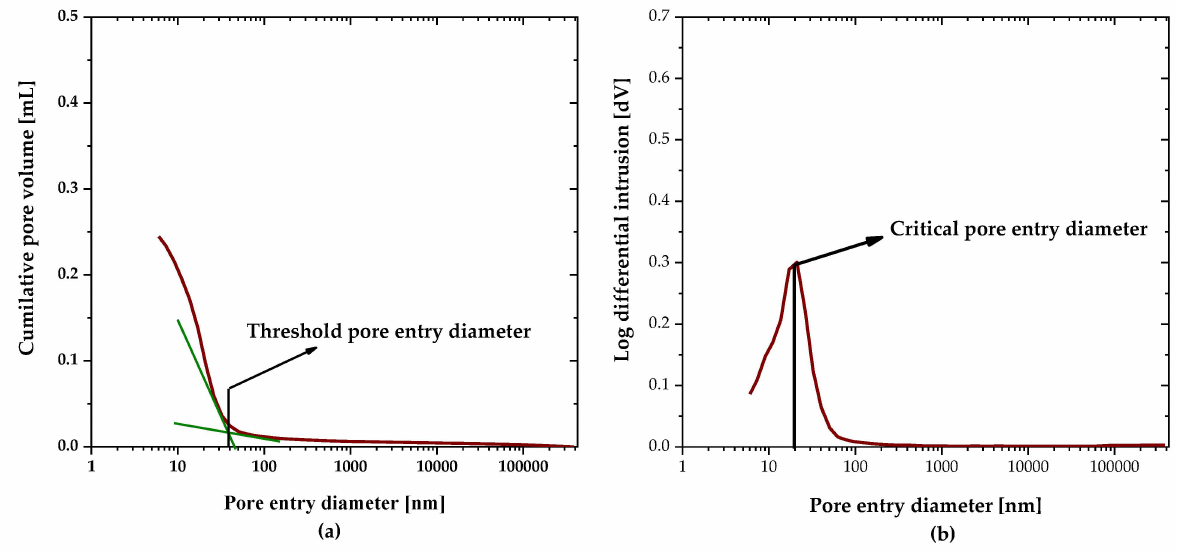
Figure 5. Determination of ( a ) threshold pore entry diameter and ( b ) critical pore entry diameter from MIP